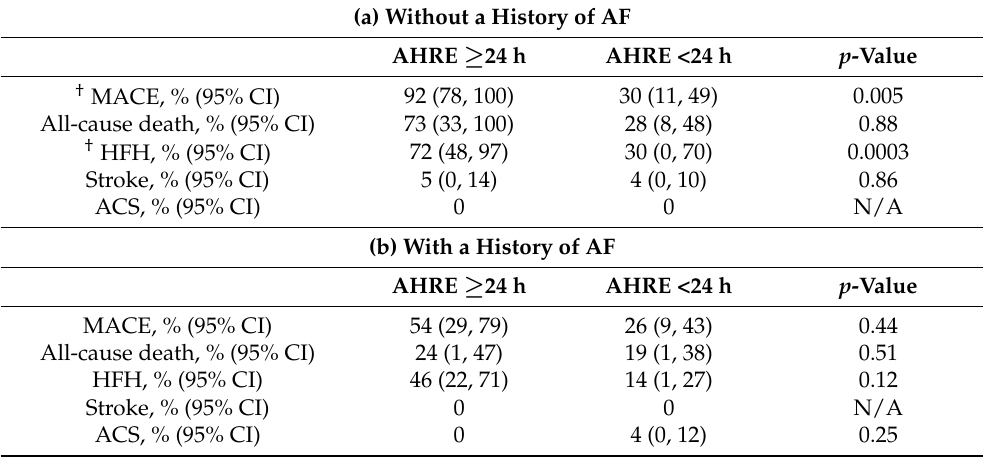
Table 3. The cumulative incidence of each clinical event in patients without (a)/with (b) a history of AF.